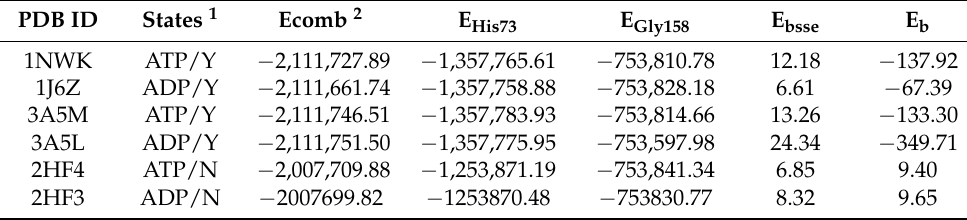
Table 2. His73/Gly158 binding energy calculation results in different nucleotide-binding